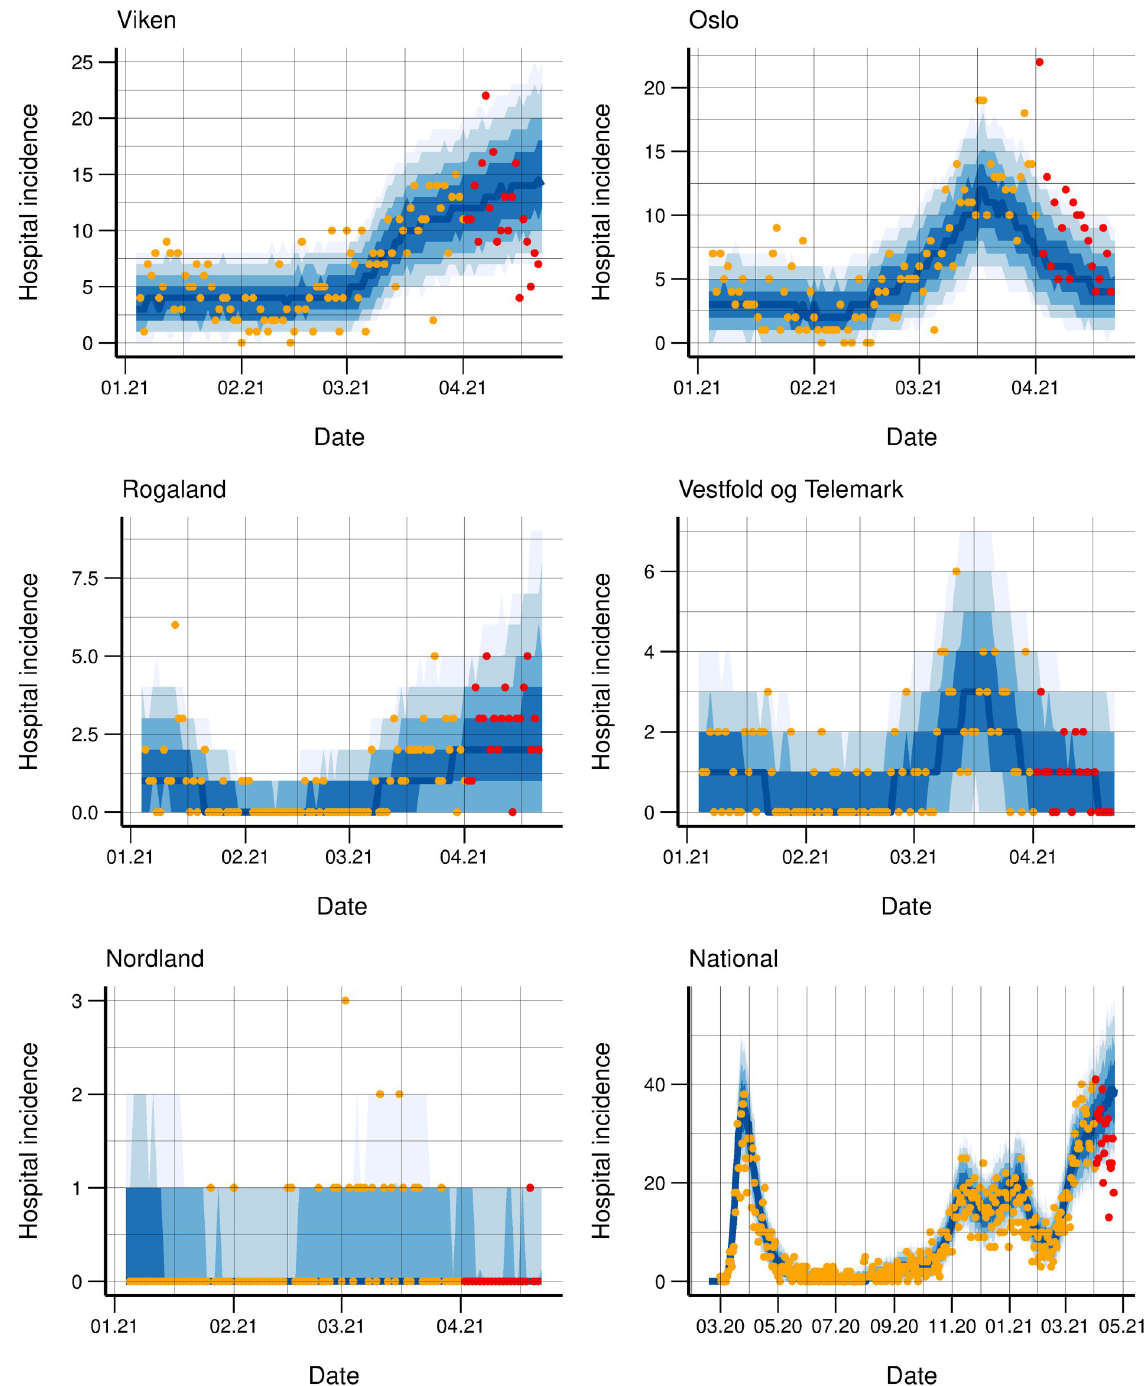
Fig 3. Hospital incidence fit. Observed daily (orange dots) and simulated (blue bands) hospitalisation incidence January to April, 2021 for five counties and nationally March 2020 to April 2021. 3-week-ahead predictions (blue bands) from April 1, 2021 are included together with actual data (red dots), which are not used in the calibration. The bands correspond to 50, 75, 90 and 95% credibility intervals.